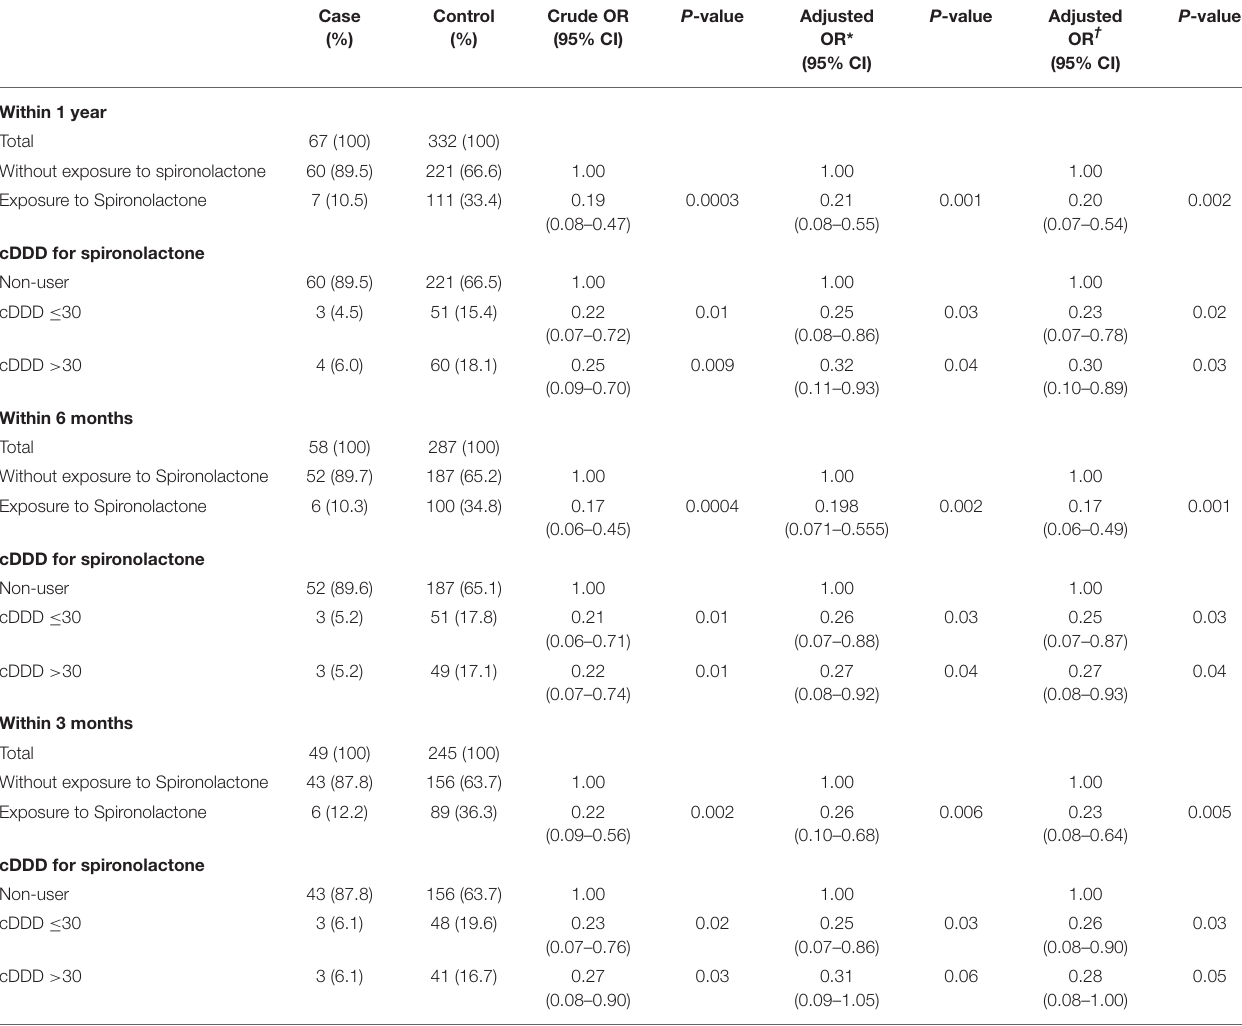
TABLE 2 | Odds ratios and 95% confidence intervals for COVID-19 according to exposure to spironolactone.